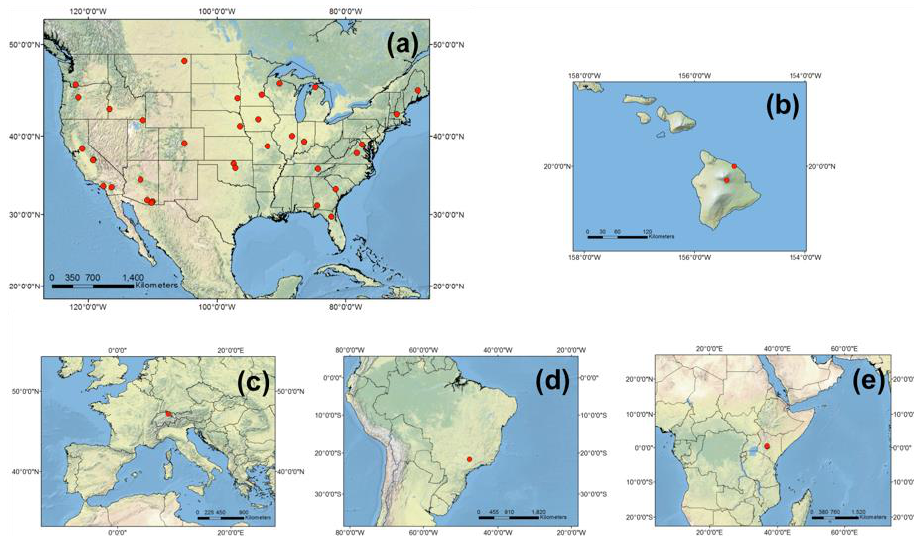
Fig. 3. The locations of the 42 sites in (a) the contiguous USA, (b) Hawaii, (c) Europe, (d) South America and (e) Africa for which optimization of the COSMIC model parameters given in Table 1 were made. (For site details, go to http://cosmos.hwr.arizona.edu/Probes/probemap.php and click on the site of interest.)